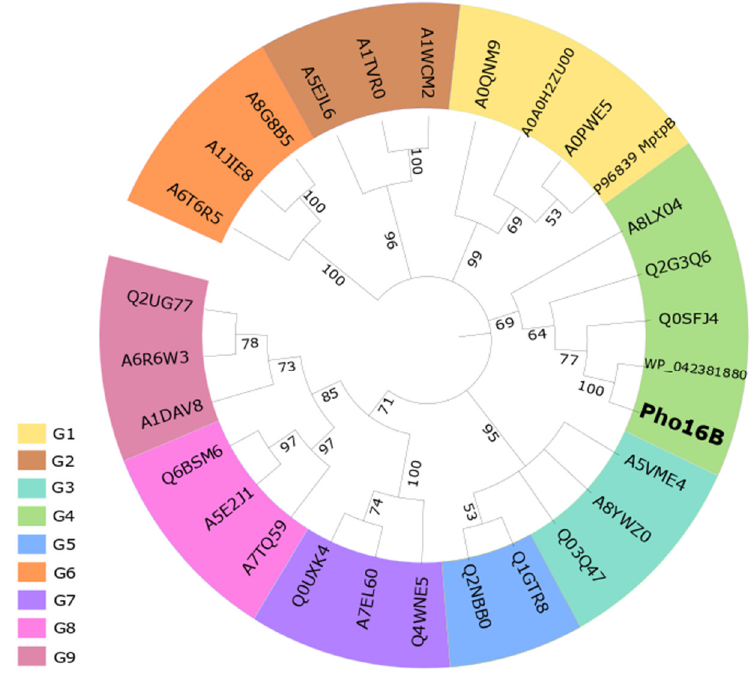
Figure 3. Neighbor-joining phylogenetic tree showing the position of Pho16B. The numbers at the nodes indicate levels of bootstrap support (range from 0 to 100) and were based on 500 replicates. Names correspond to the groups (G) described by Beresford et al. (2010) and their corresponding